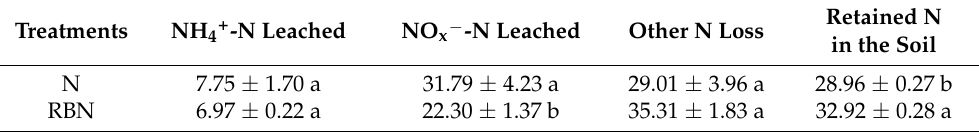
Table 3. Losses and residues of 15 N-labeled nitrogen added to the soil (mg).